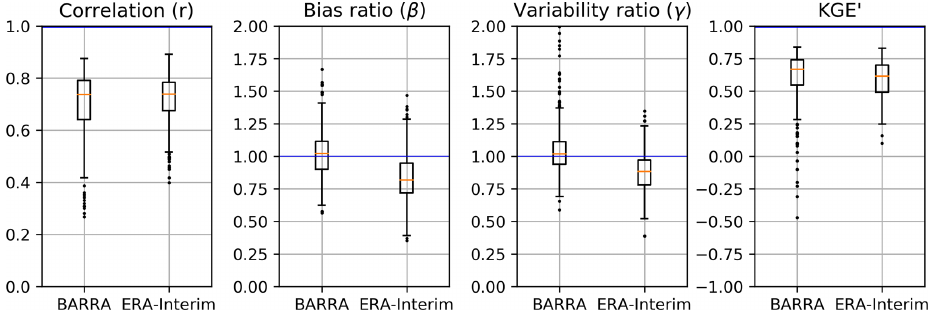
Figure 7. Boxplot of correlation ( r ), bias ratio ( β ), variability ratio ( γ ), and modified Kling–Gupta efficiency (KGE (cid:48) ) against AWAP dataset. Each box extends from first to third quartile, medians are marked in each box, and whisker extends to furthest point or 1.5 times the interquartile range, whichever is closer. Table 3. Summary of performance of BARRA